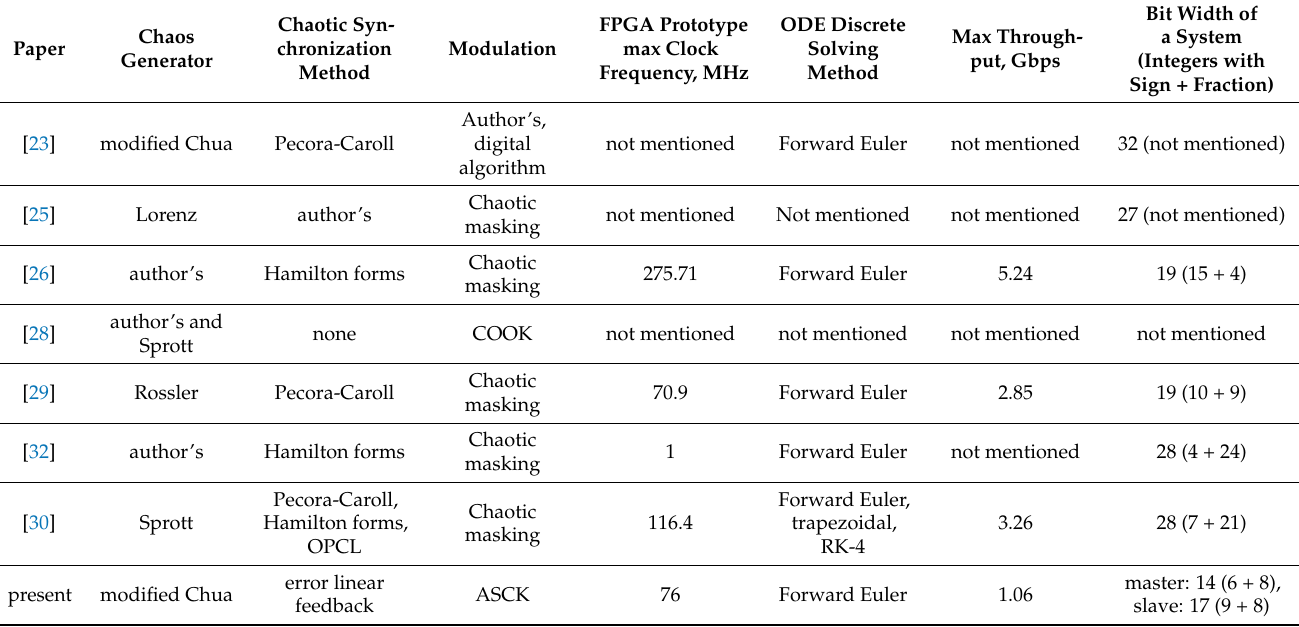
Table 2. Summary of chaotic communication systems implemented in